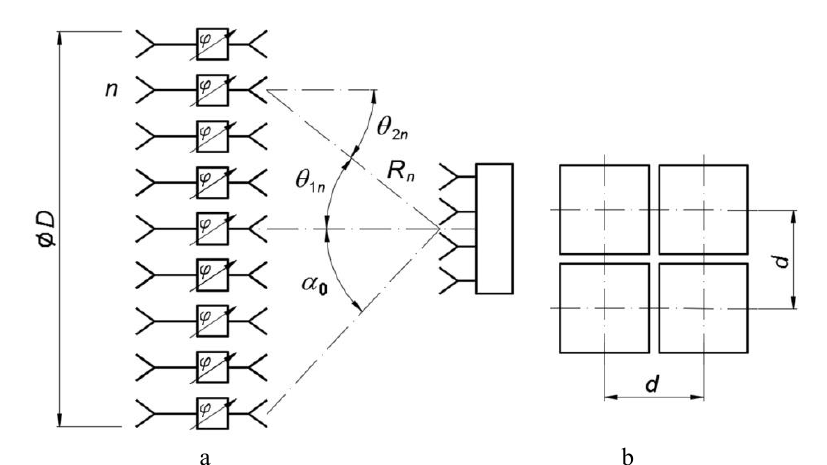
Fig. 1. Schematic of pass-through PAA with spatial excitation (a) and layout of radiators in the monopulse irradiator